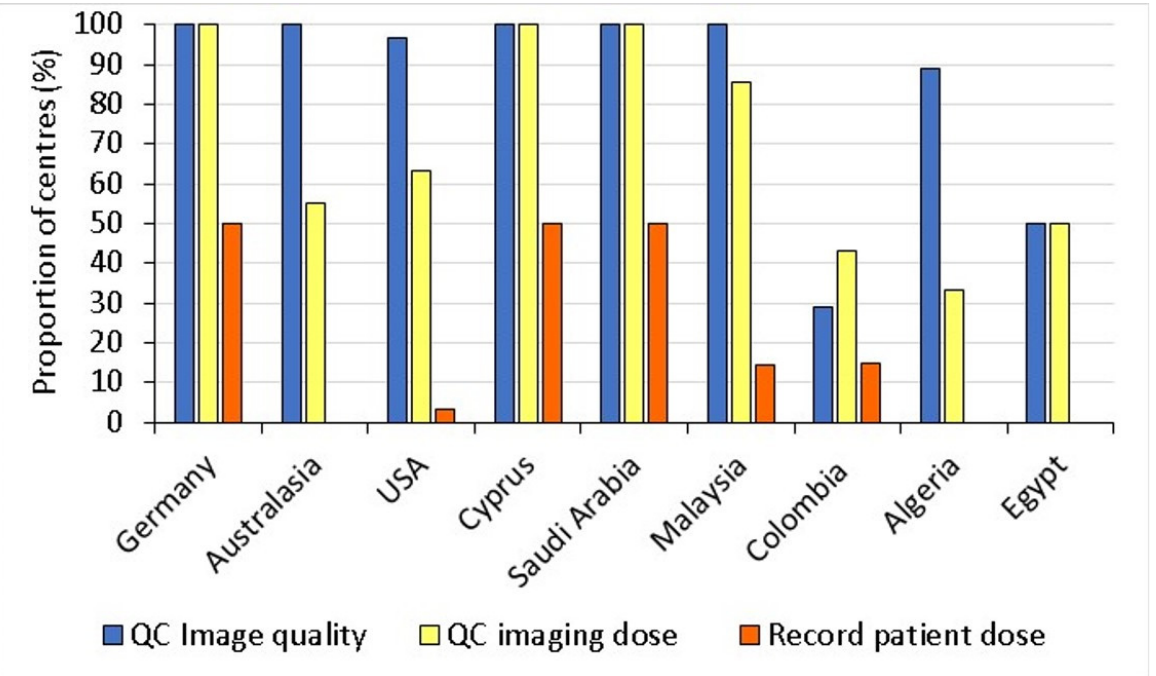
Figure 4. Proportion of radiotherapy centres in each country carrying out QC tests on image quality and dose, and those recording patient dose quantities [14].